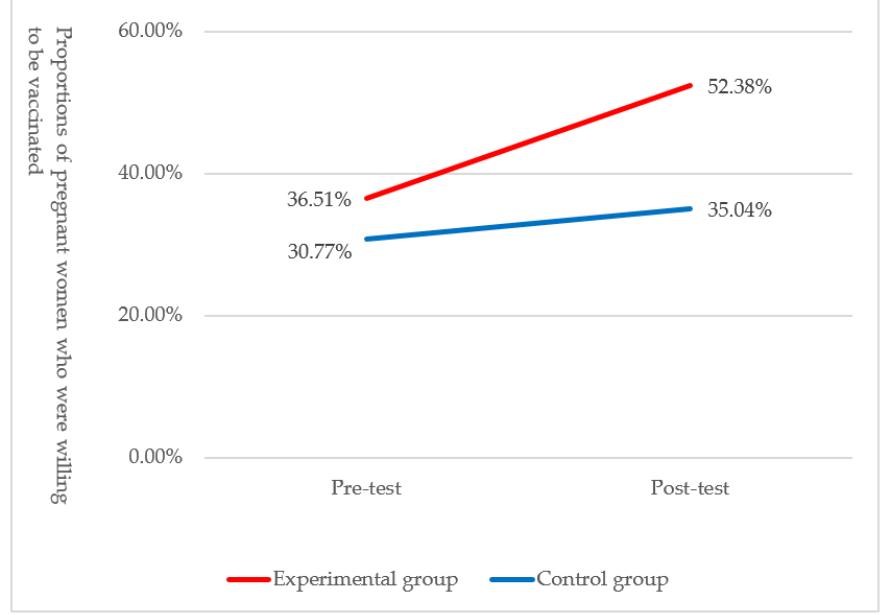
Figure 2. Change in the pre- and post-test proportions of the influenza vaccination intention between two groups of pregnant women.